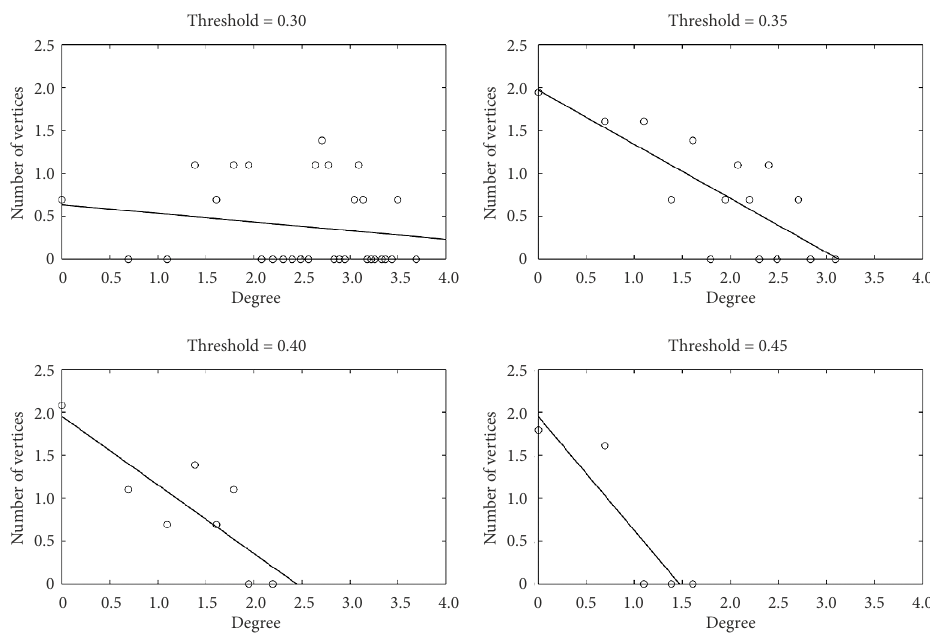
Figure 2. Degree distribution under different thresholds (logarithmic scale) Table 1. Power law distribution parameters for different thresholds Threshold